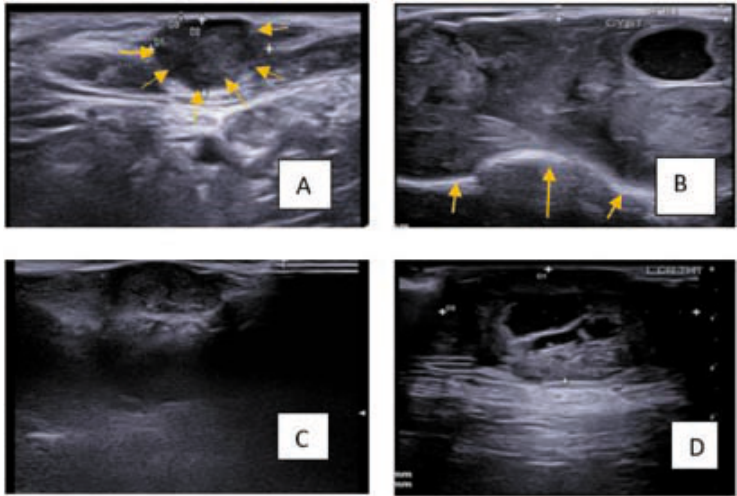
Fig. 2. (a) A benign mammary neoplasm with regular margin (arrows). (B) A malignant mammary neoplasm with undefined margins (arrows). (c) A benign mammary neoplasm without posterior acoustic enhancement. (D) A malignant mammary neoplasm with posterior acoustic enhancement